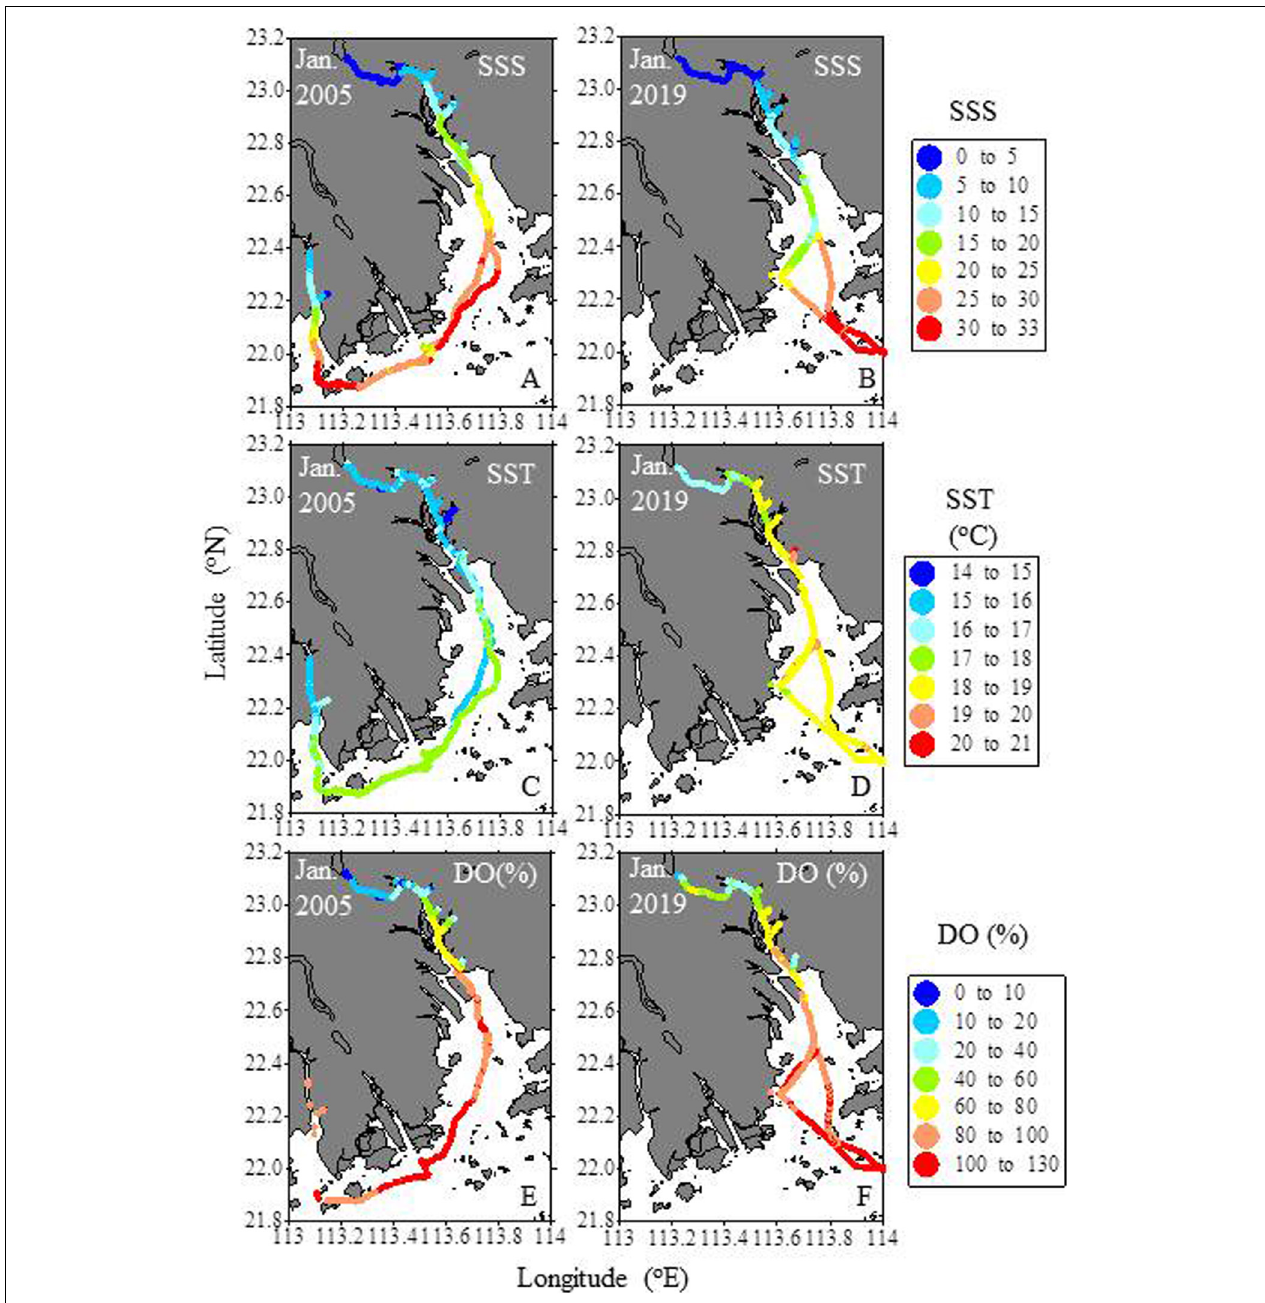
FIGURE 4 | Spatial distributions of salinity (SSS). temperature (SST) and DO saturation degree (DO%) of surface water in the Pearl River estuary in January of 2005 and 2019. The January 2005 data are from Guo et al. (2009).